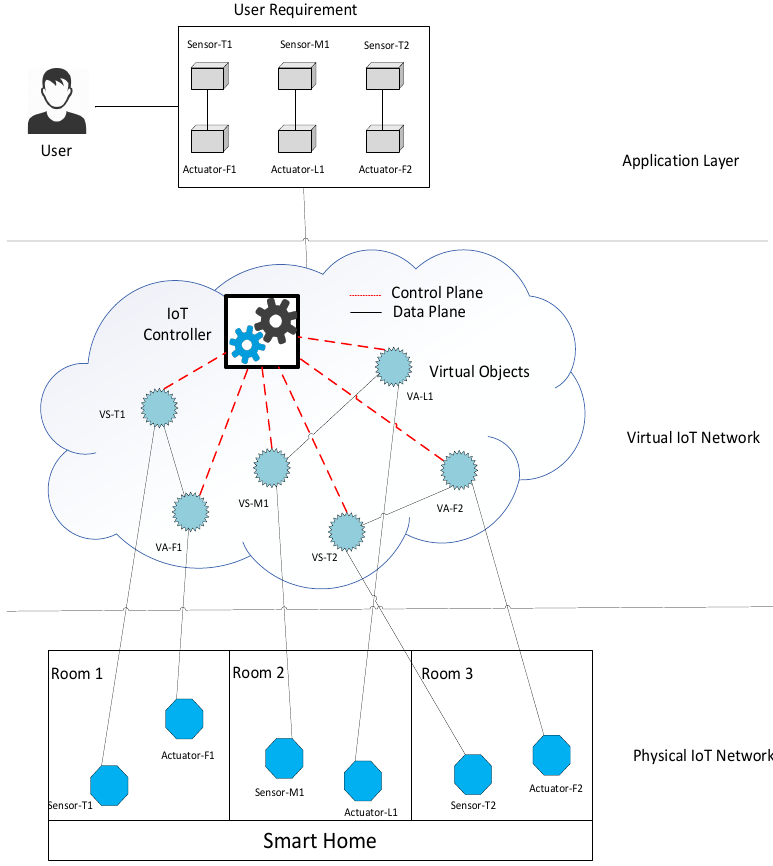
Figure 3. Proposed Architecture of Virtual IoT